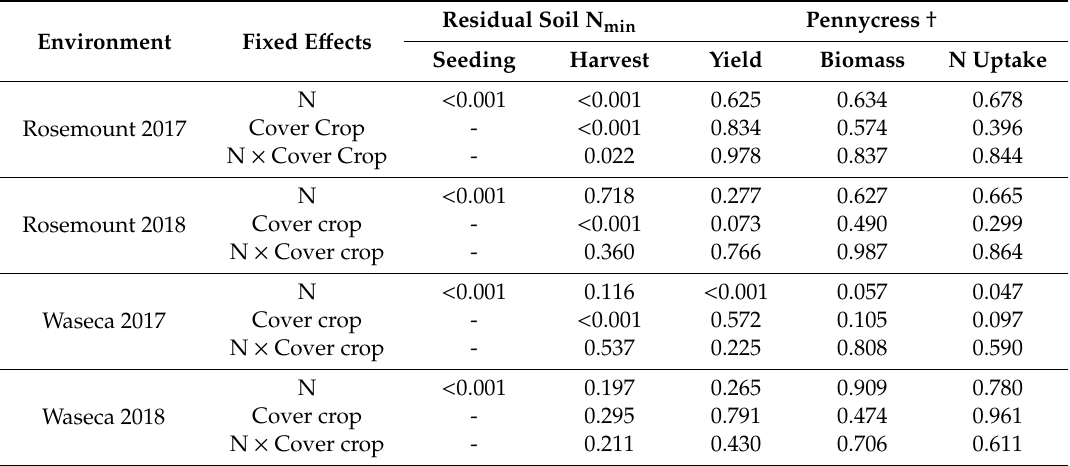
Table 3. Results ( p -values) of the mixed-model analysis of variance of residual soil inorganic N (N min ) at pennycress seeding and harvest, pennycress grain yield, biomass and N uptake.